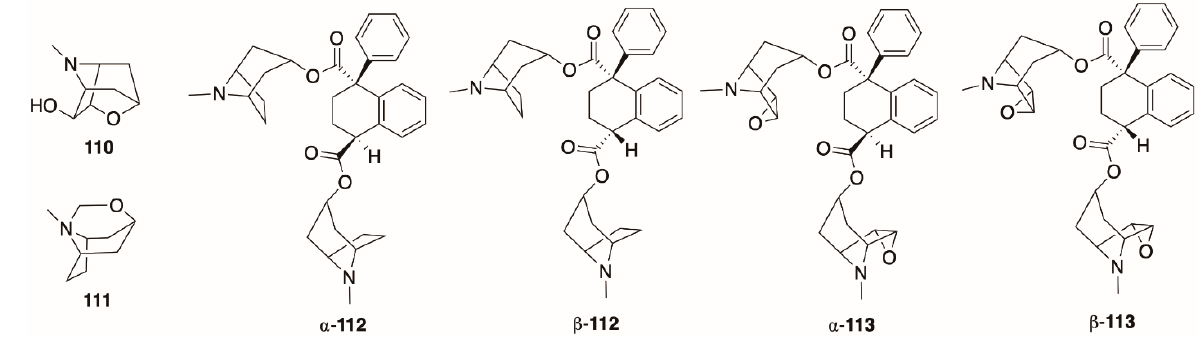
Figure 10. Cyclic and dimeric tropane alkaloids from Datura .